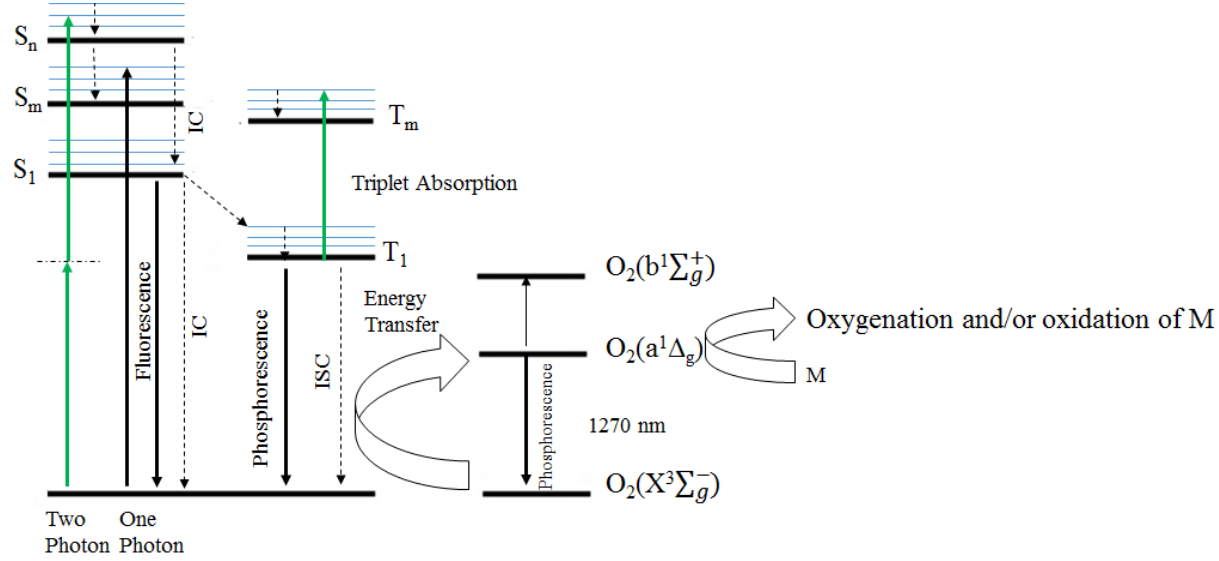
Figure 2. Formation of PDT reactive species through type I and type II photochemistry (modified from